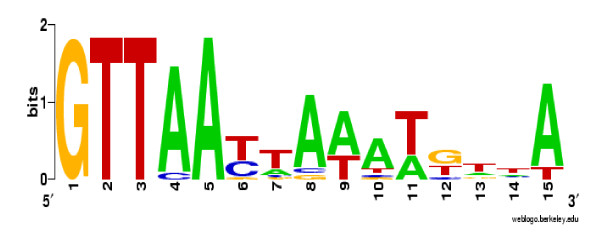
Logo of the information matrix obtained from the alignment of ArcA sequences for S. Typhimurium. Sequences were obtained by searching the S. Typhimurium LT2 genome [Accession #: AE006468 (chromosome) and AE606471 (plasmid)] with known ArcA sequences derived from the corresponding ArcA-regulated genes in E. coli. A total of 20 E. coli sequences were used to obtain the logo shown. The total height of each column of characters represents the amount of information [measured in bits, which is the maximum entropy for the given sequence type (ex. Log2 4 = 2 bits for DNA/RNA and log2 20 = 4.3 bits for proteins)] for that specific position and the height of each individual character represents the frequency of each nucleotide.